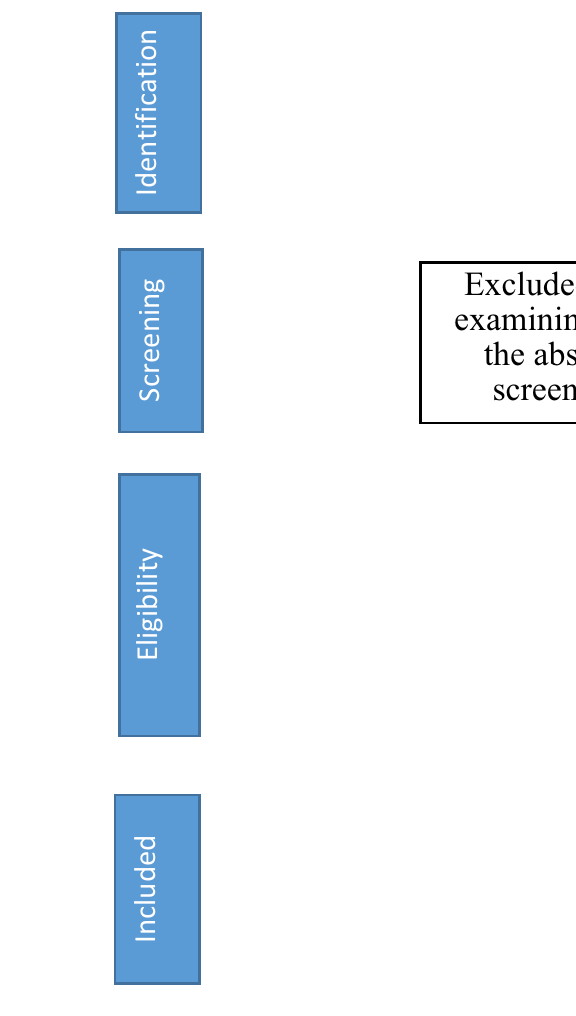
Fig. 1 Flow diagram of the literature search and study selection processes